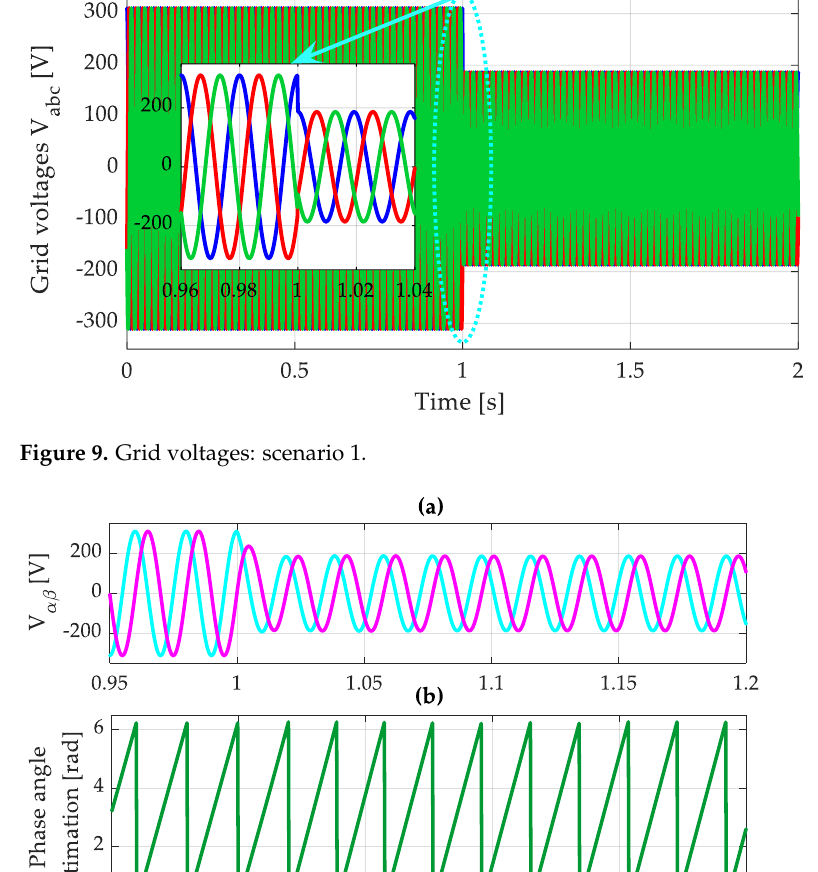
Figure 9. Grid voltages: scenario 1.